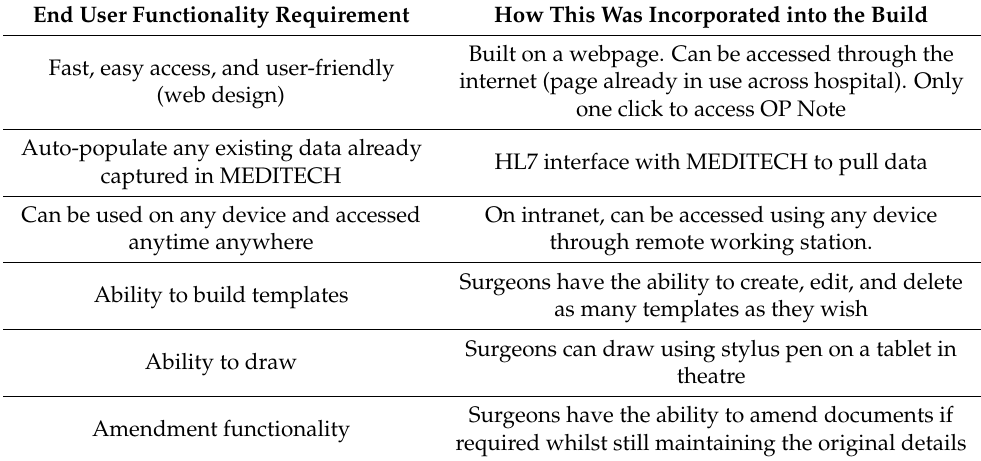
Table 4. Requirements